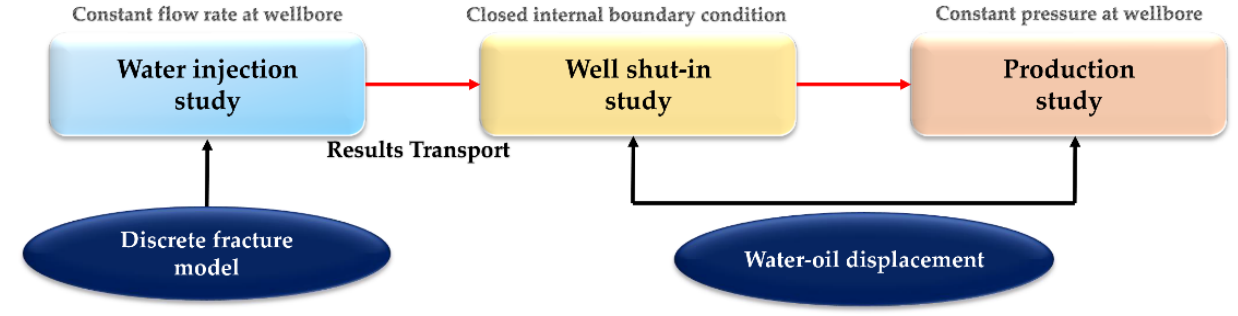
Figure 1. Flow-process diagram for the transport of the simulation results in the Figure 1. Flow ‐ process diagram for the transport of the simulation results in the model.